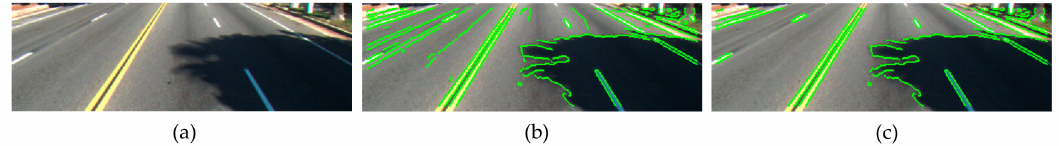
Figure 11. ( a ) ROI of an input image of the Caltech Lane dataset. ( b ) ROI overlaid with Canny edge map. ( c ) Enhanced edge map D after applying the intensity filter, i.e., Equation